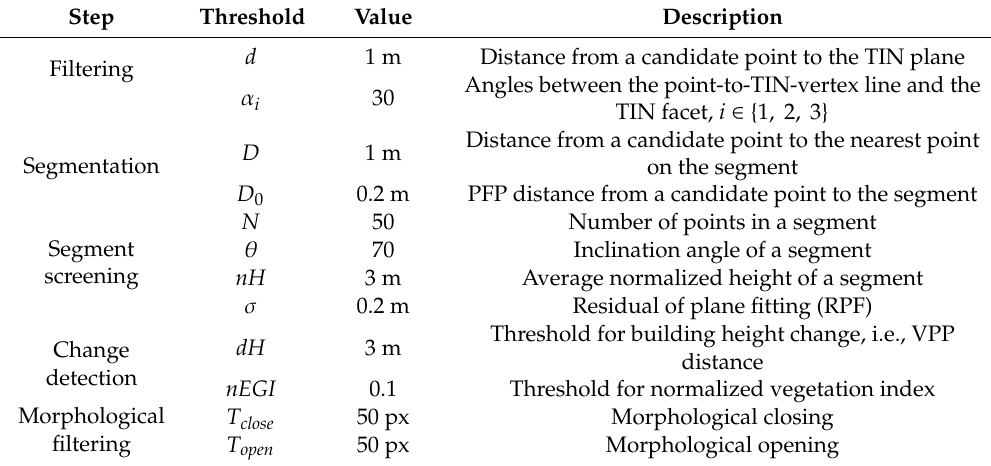
Table 2. Parameter settings and